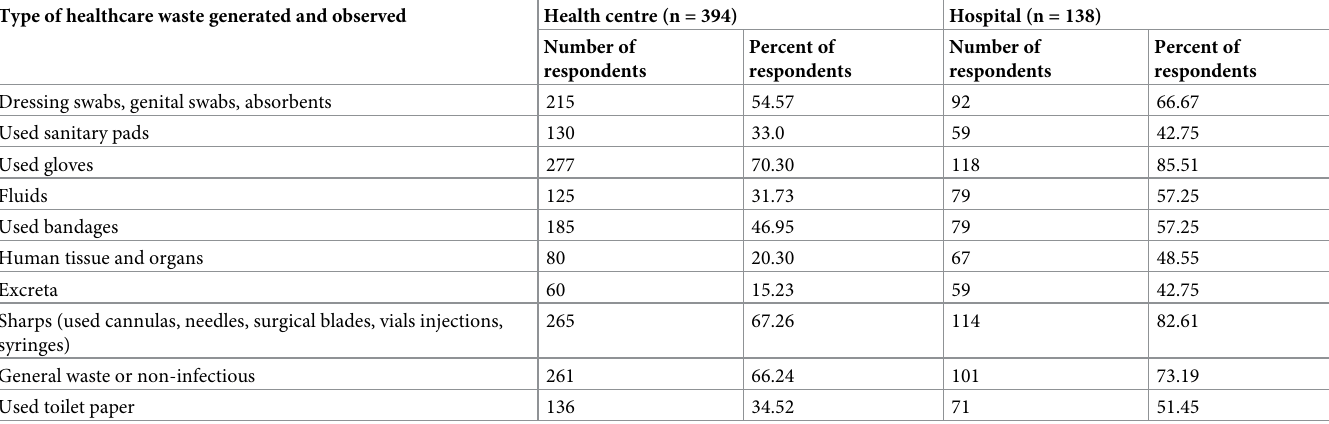
Table 5. Types of HCW generated daily at the selected healthcare facilities, Addis Ababa City Administration, February 2018. Type of healthcare waste generated and observed